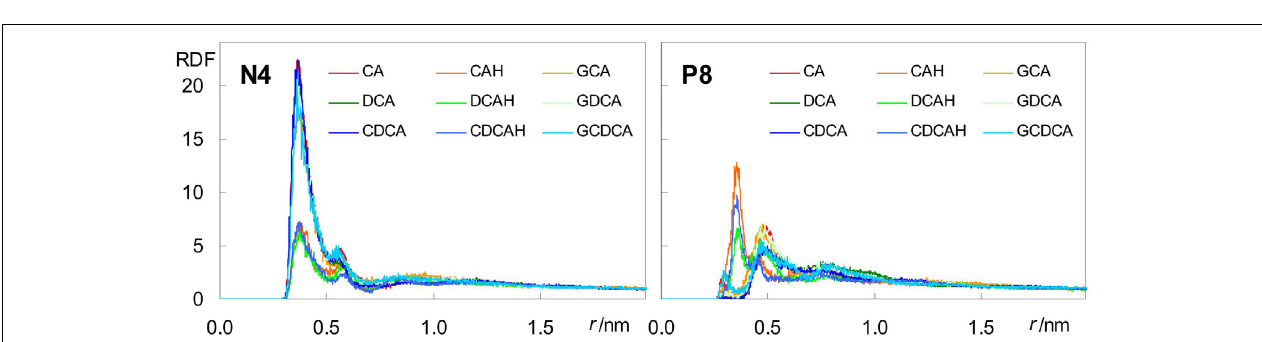
FIGURE 6 | Average number of hydrogen bonds per BS between water donors and BS acceptor atoms.